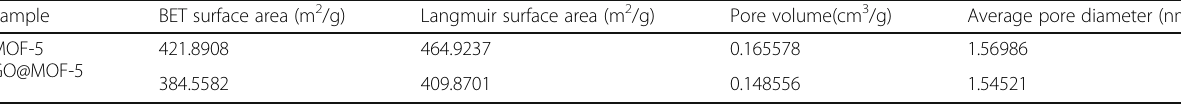
Table 1 Nitrogen adsorption properties of MOF-5 and GO@MOF-5